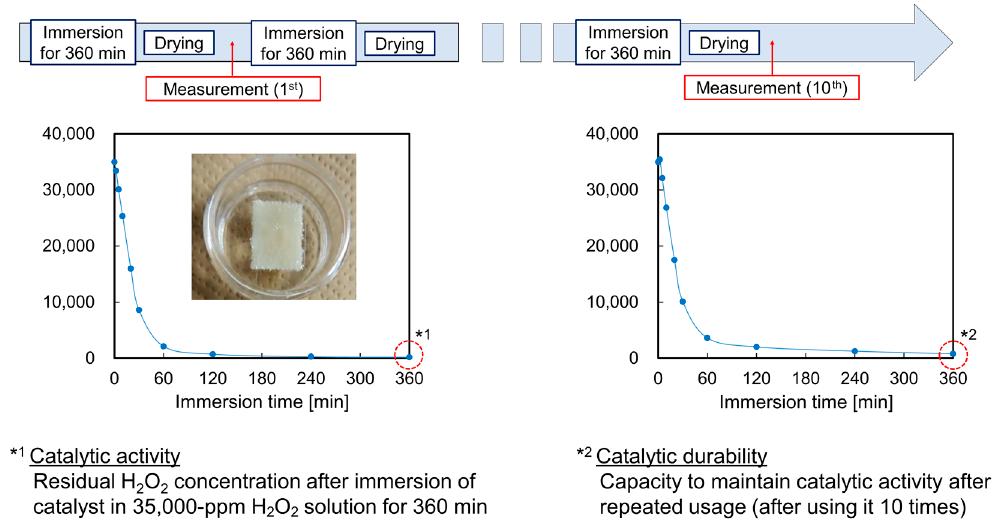
Figure 11. Schematic of the process for evaluating the catalytic activity and durability of the system using typical H 2 O 2 decomposition curves. * 1 Value of the residual H 2 O 2 concentration for evaluating the catalytic activity. * 2 Value of the residual H 2 O 2 concentration for evaluating the catalytic durability.